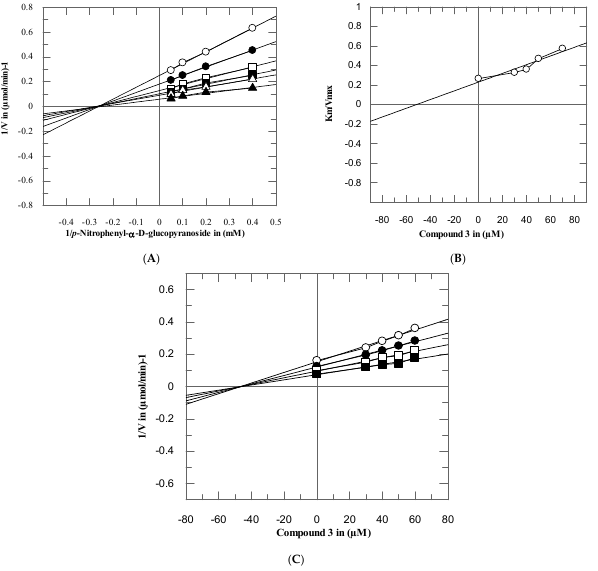
Figure 3. The inhibition of α -glucosidase by compound 3 ( A ) Lineweaver–Burk plot of reciprocal of rate of reaction (velocities) vs. reciprocal of substrate ( p -nitrophenyl- α -D-glucopyranoside) in the absence ( ▲ ), and in presence of 30 ( ∆ ), 40 ( ■ ), 50 ( □ ), 60 ( ● ), and 70 μ M ( ○ ) of compound 3 . ( B ) Secondary replot of Lineweaver–Burk plot between the slopes of each line on Lineweaver–Burk plot vs. different concentrations of compound 3 . ( C ) Dixon plot of reciprocal of rate of reaction (velocities) vs. different concentrations of compound 3 .